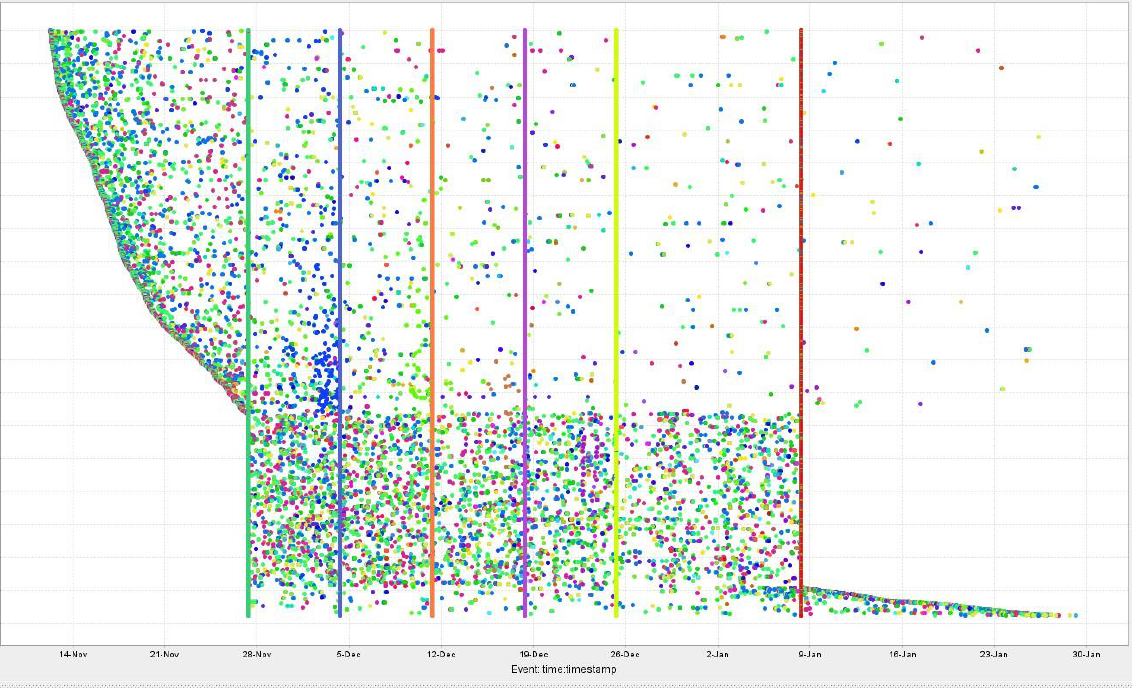
Figure 7. Video watching trends for cluster 1.